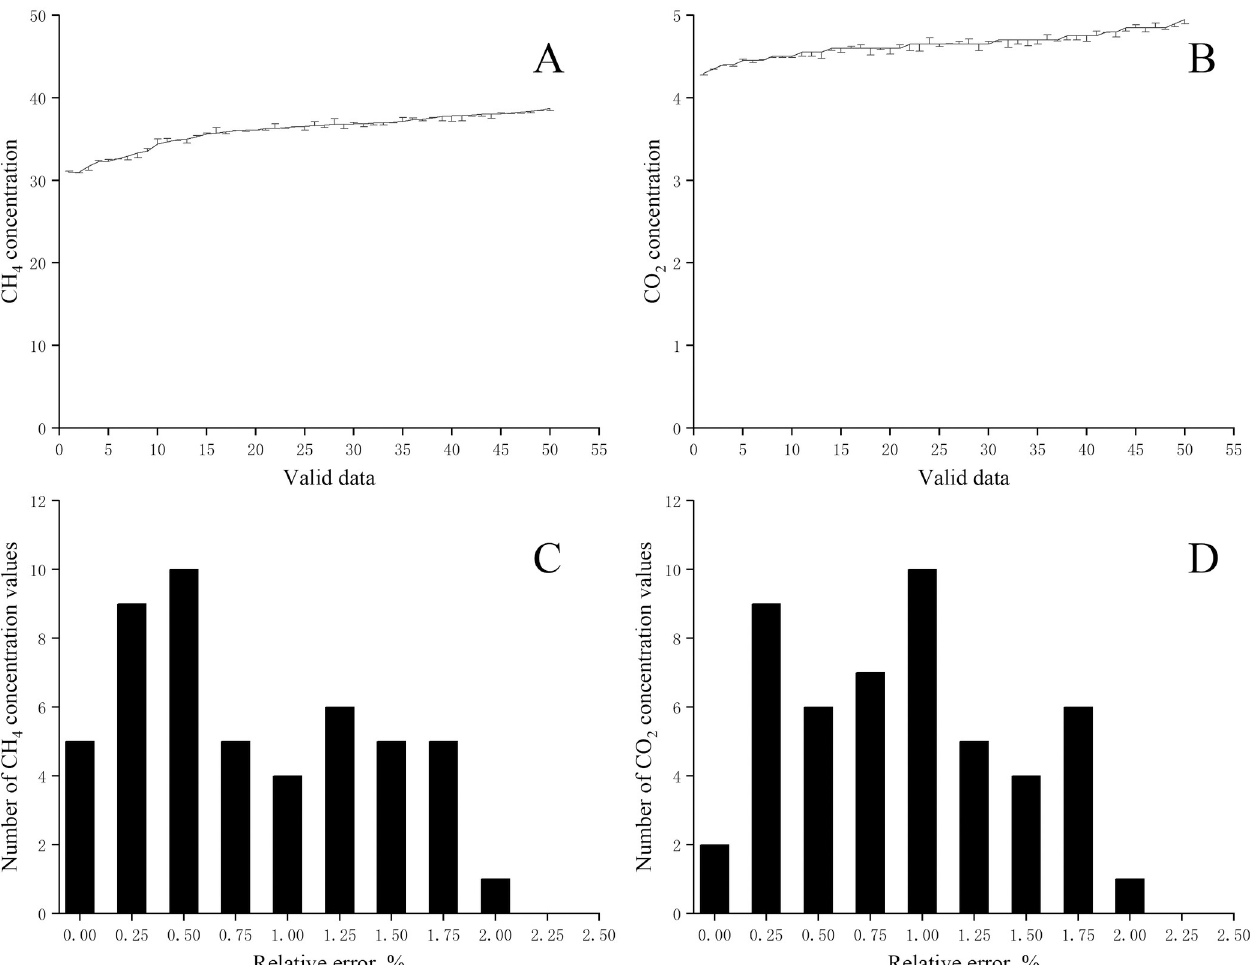
Fig 4. The absolute error and relative error statistics of effective value analysis model calculation results. Fig A and B are the effective value analysis model calculation result with absolute error for 50 sets of CH 4 and CO 2 data. Fig C and D show the statistical results of the data in graphs A and B respectively with 0.5% relative error